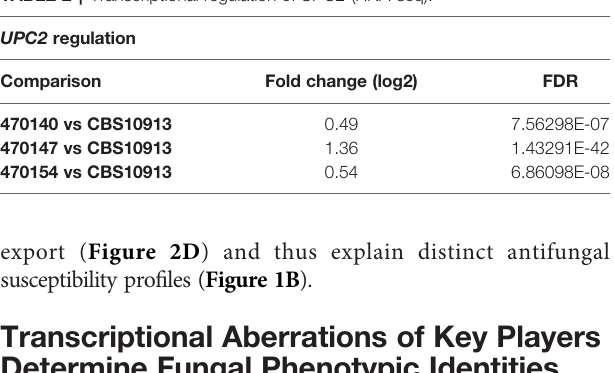
TABLE 2 | Transcriptional regulation of UPC2 (RNA-seq).